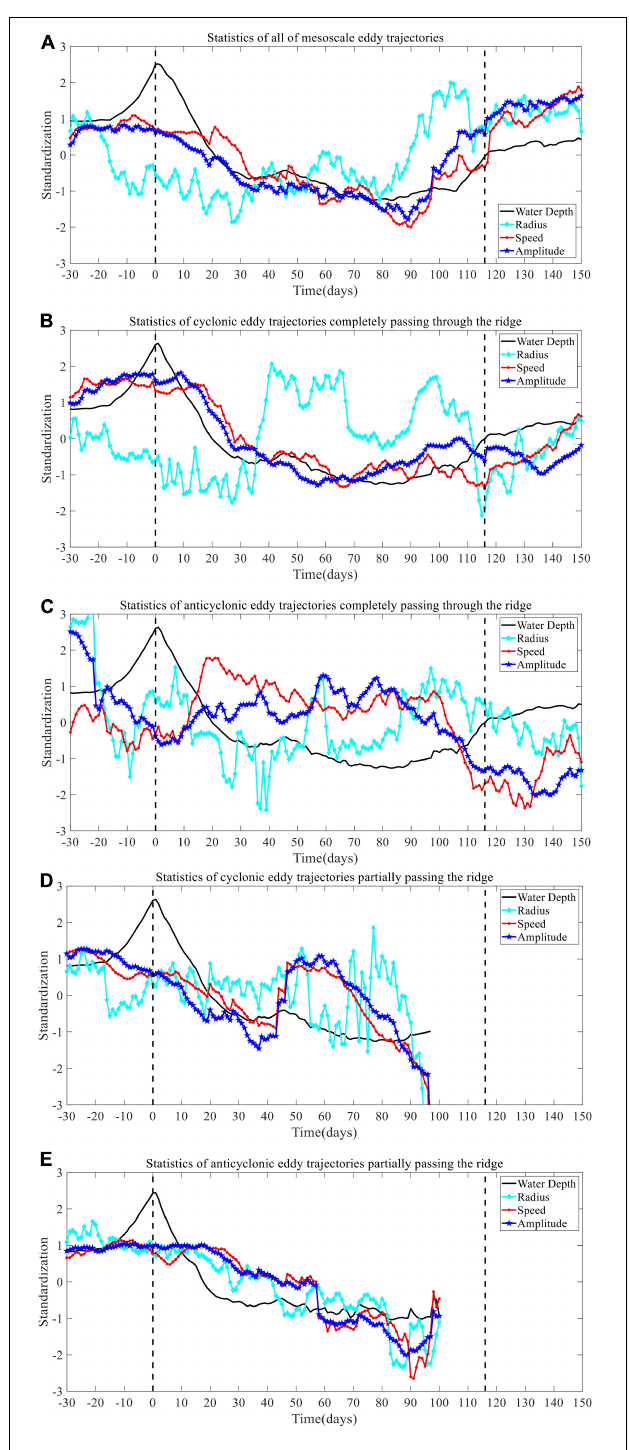
FIGURE 5 | Mean curve mapping of amplitude, rotation speed, radius, and topography after standardization. (A) The statistics in all of 69 mesoscale eddy trajectories. (B) The statistics in cyclonic eddy trajectories that completely pass through the ridge. (C) The statistics in anticyclonic eddy trajectories that completely pass through the ridge. (D) The statistics in cyclonic eddy trajectories that partially pass the ridge. (E) The statistics in anticyclonic eddy trajectories that partially pass the